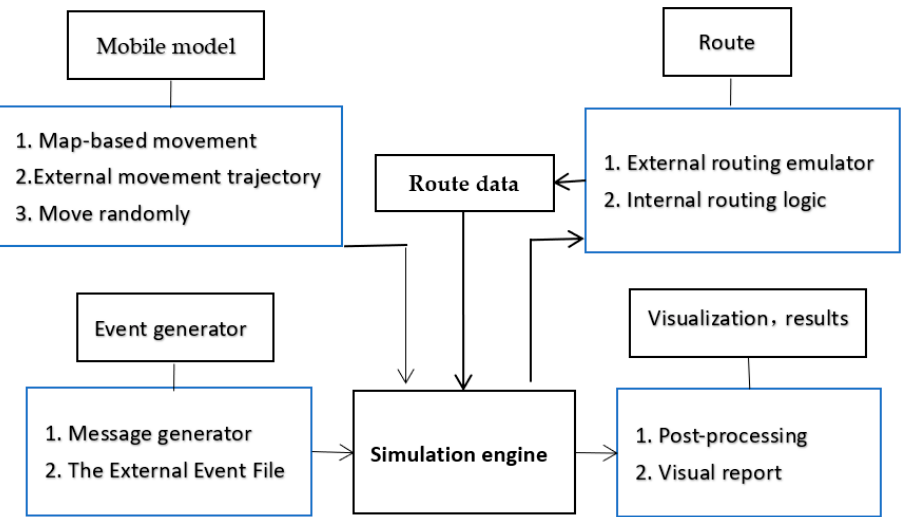
Figure 3. Simulation platform architecture.